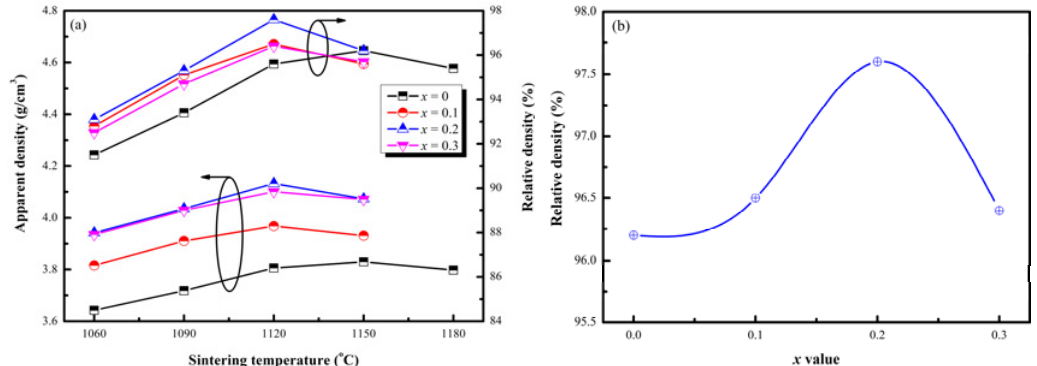
Fig. 3 (a) Apparent density and relative density of LZTNN x ceramics sintered at various temperatures and (b) relationship between relative density at optimized sintering temperature and x